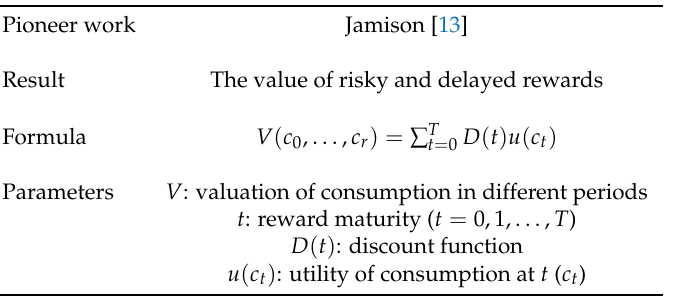
Table 2. DEU model. Source: Own